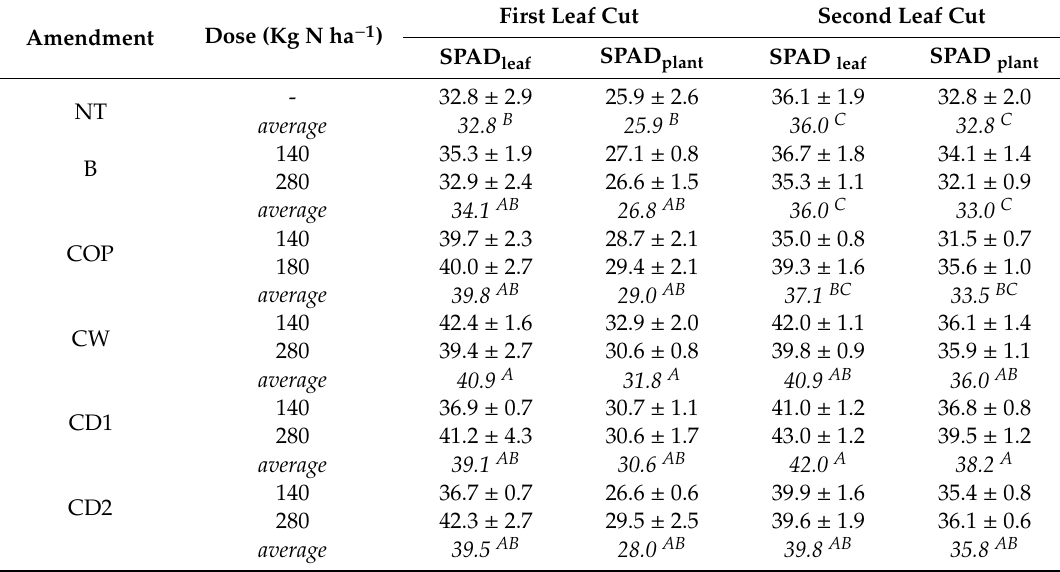
Table 3. SPAD meter values relatively to the youngest fully expanded leaf (SPAD leaf ) and the whole plant (SPAD plant ), at the first and second cut of Swiss chard leaves grown on soil mixed with di ff erent organic amendments, each added in two doses to, respectively, provide 140 and 280 kg N ha − 1